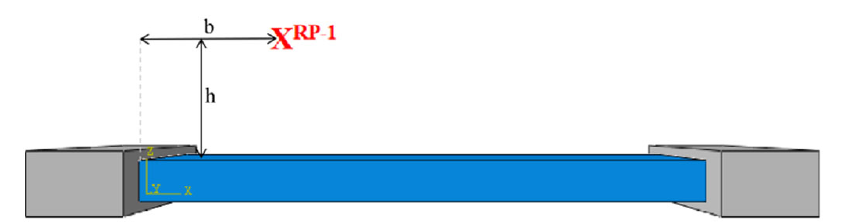
Figure 16. Explosive loading mode.